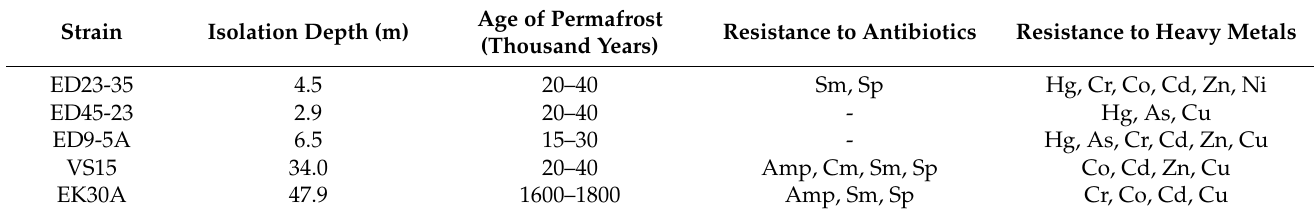
Table 1. Analyzed permafrost strains of A. lwoffii